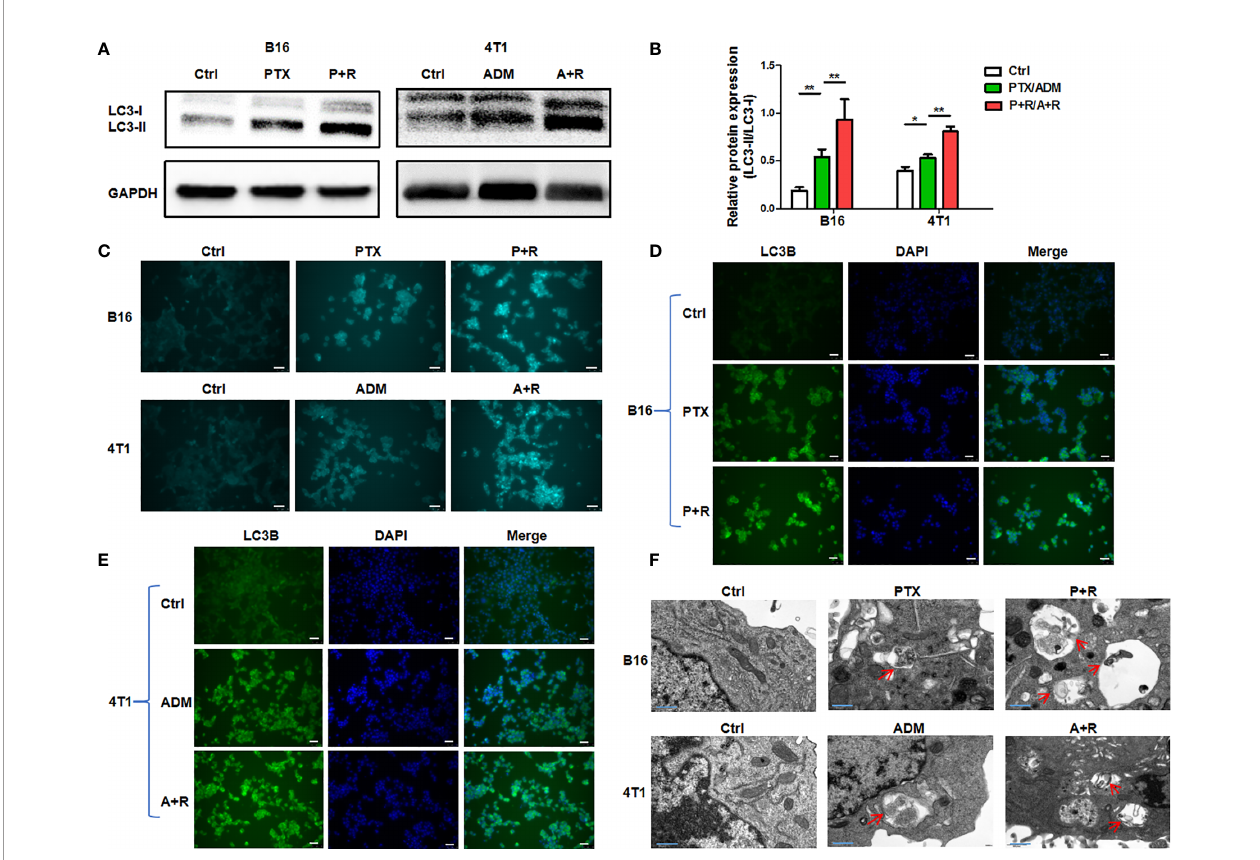
FIGURE 2 | The induction of hyperautophagy by low-dose CAER treatment. (A) The autophagy marker LC3-II/LC3-I was detected in B16F10 (left panel) and 4T1 (right panel) cells using WB. Cells were incubated with a low concentration of paclitaxel (PTX; 5 m g/mL) or adriamycin (ADM; 0.1 m g/mL) for 6 – 8 h and then with rapamycin (25 nM) for 16 – 24h (B) Graph of the statistical analysis of WB. (C) The autophagic fl ux in B16F10 and 4T1 cells was detected by monodansylcadaverine (MDC) assay. (scale bars: 25 m m). (D, E) The autophagy marker LC3B was detected in B16F10 cells using immuno fl uorescence. The treatment was the same as in Figure 1A (scale bars: 25 m m). (F) Transmission electron micrographs of autophagosomes/autolysosomes induced by the chemotherapeutic agents and rapamycin in B16F10 and 4T1 cells (scale bars: 0.4 m m). * P < 0.05, ** P < 0.01 by Student ’ s